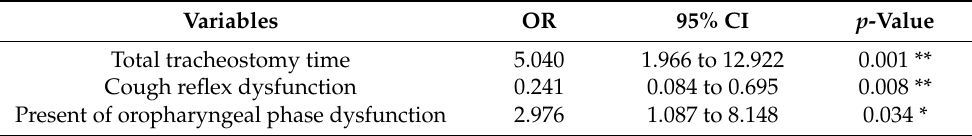
Table 6. The multivariate logistic regression analysis for the risk factors of pneumonia. Variables OR 95% CI p -Value Total tracheostomy time